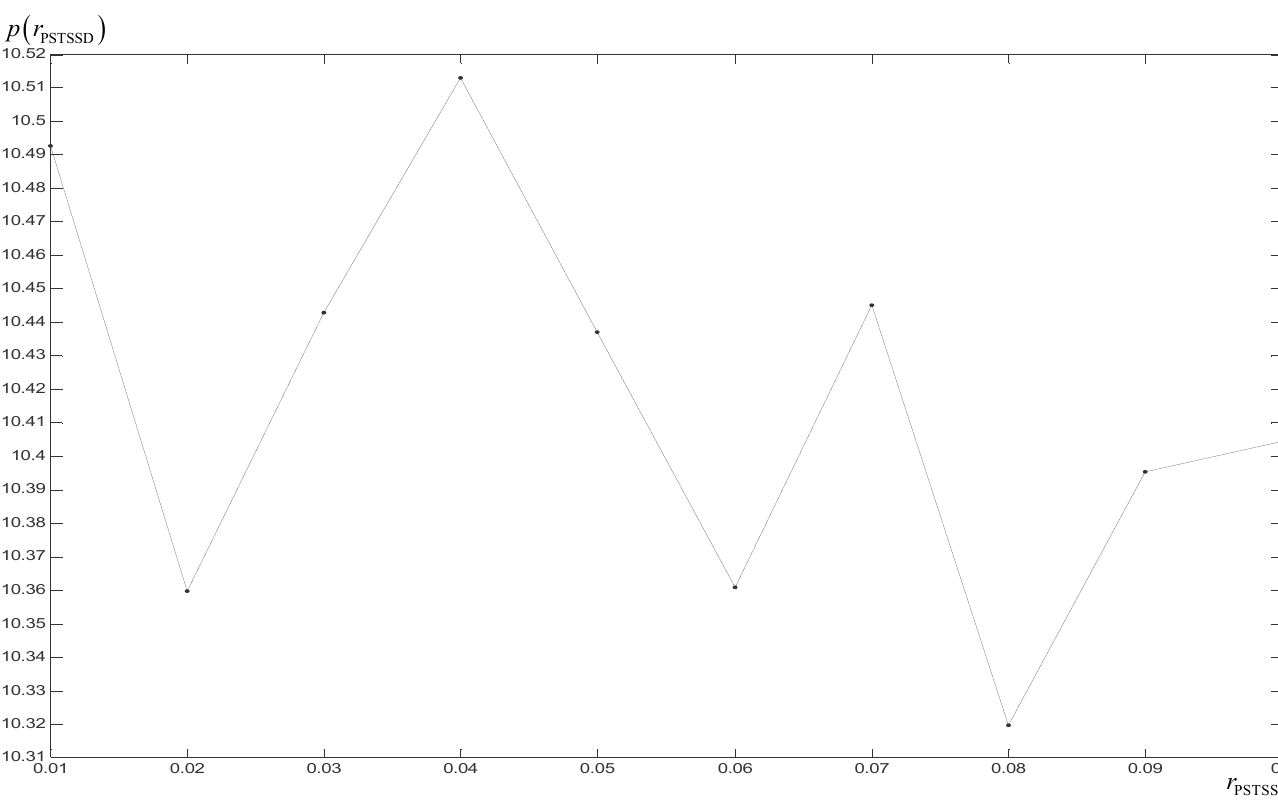
Fig. 2. A 2.5-times multiple re-evaluation of function (8) for 2LP (22) on the 10-pointed subset (28). A solution is seen clearer, but contrary to the view in Fig. 1.